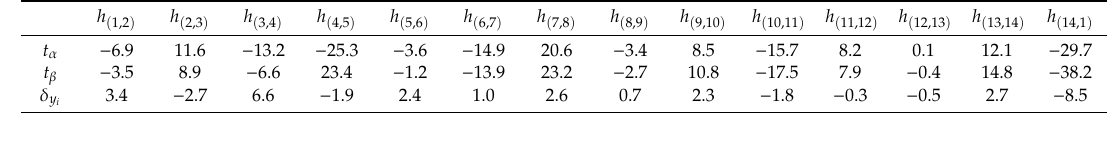
Figure 7. Monitored loading quay: ( a ) object’s photo (source: Google Maps), ( b ) free control network (FCN) diagram with ECPs marked. Table 3. Observation of heights’ di ff erences within a real FCN (in mm).